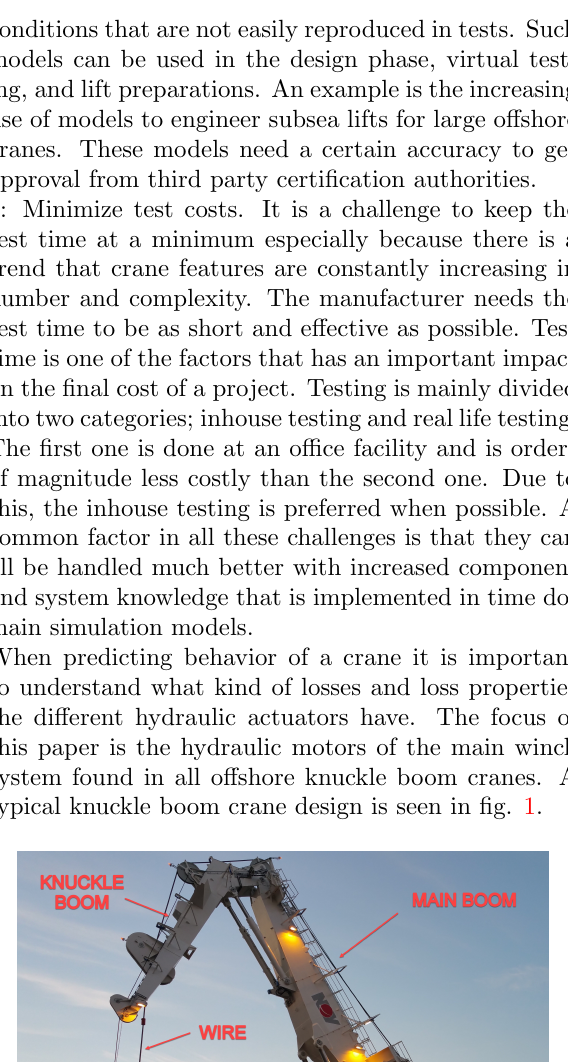
Figure 2: Simple sketch of a winch